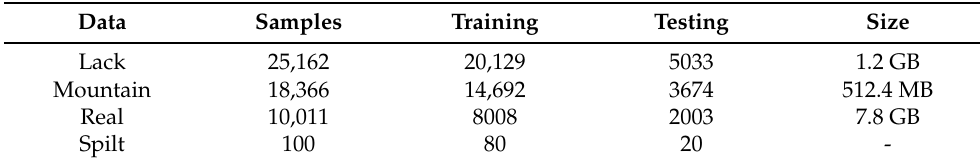
Figure 4. The YUV format of images from two datasets: the Mountain dataset ( left ) and the Lack dataset ( right ). Table 2. Descriptions of the Udacity dataset and the real